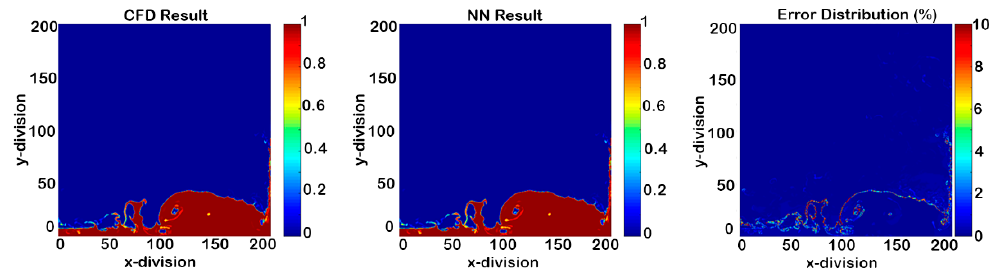
Figure 12. Phase fraction results in time-step 1150 (time-step size of 0.004 s).